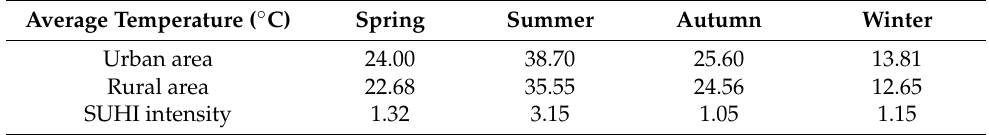
Table 4. The results of SUHI intensity using the urban–rural dichotomy. Average Temperature ( ◦ C) Spring Summer Autumn Winter Urban area Rural